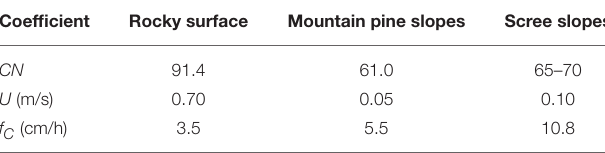
TABLE 1 | Parameters adopted in the hydrological model. Coefficient Rocky surface